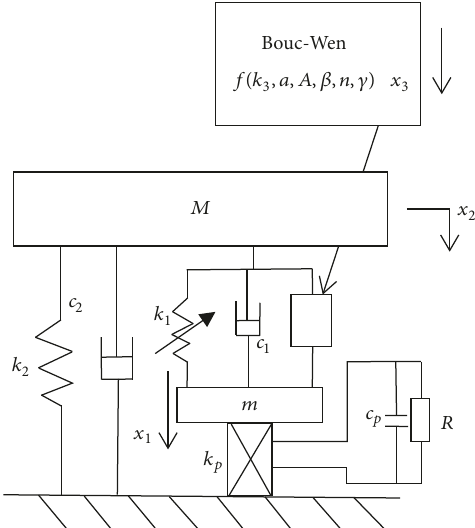
Figure 1: The single-degree-of-freedom system with the NES-pie- zoelectricity system: configuration 1.